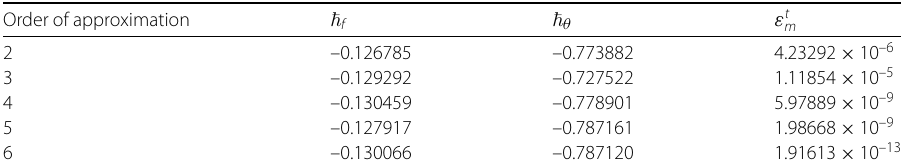
Table 1 Optimal value of convergence control parameters versus different orders of approximation Order of